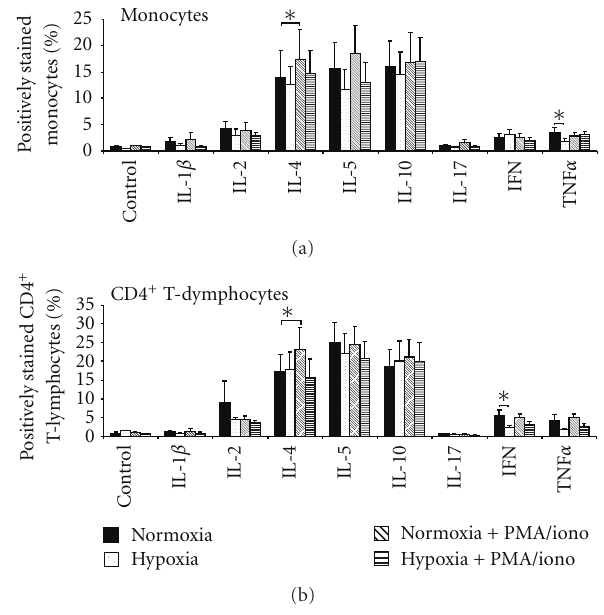
Figure 3: E ff ect of hypoxia and PMA/iono on the number of monocytes or CD4 + T lymphocytes stained positive for several cytokines determined by flow cytometry. The number of cytokine positive monocytes or CD4 + T lymphocytes was analysed by flow cytometry. n = 14; data are expressed as mean ± SEM. ∗ P < .